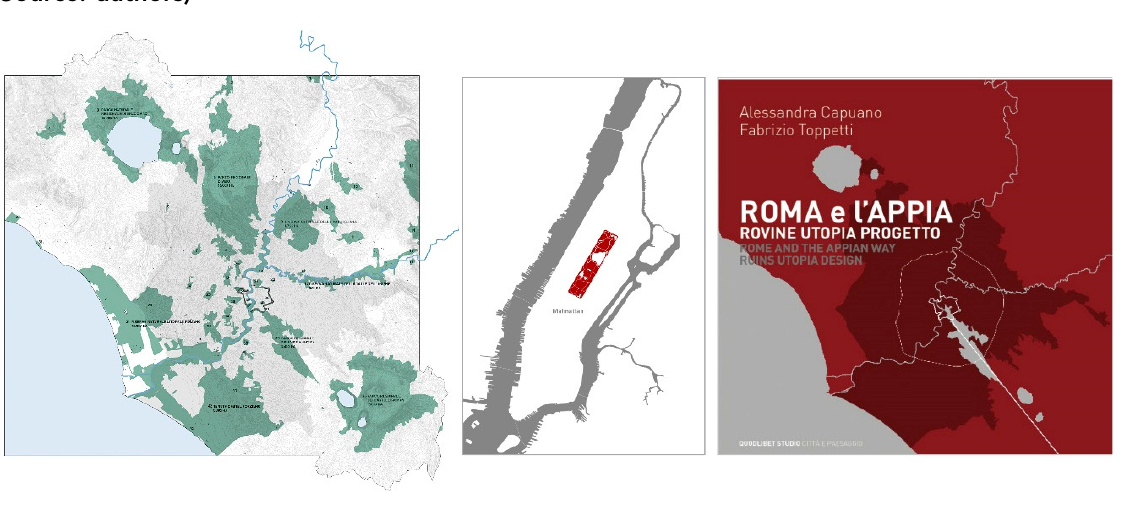
Figure 2. Left : diagrams of protected natural areas in the Municipality of Rome; centre : Central Park on Manhattan Island; right : book cover of Rome and the Appian Way: Ruins Utopia Design (Source: Authors, 2022)